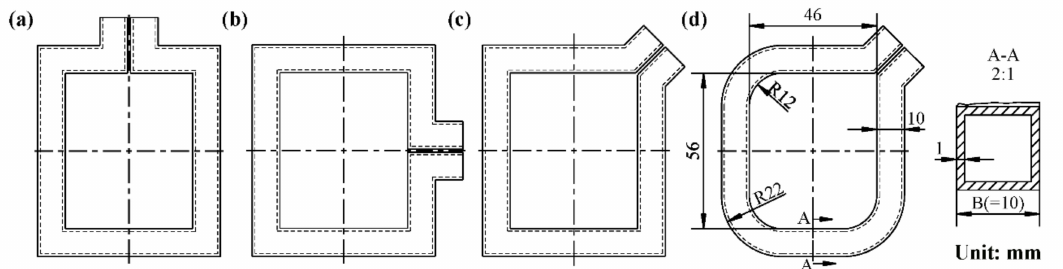
Figure 10. Different inductor structures: ( a ) The current input and output terminals are located on the short side of the inductor; ( b ) The current input and output terminals are located on the long side of the inductor; ( c ) The current input and output terminals are located on the diagonal of the inductor (non-uniform clearance between the inductor and the rectangular tube); ( d ) The current input and output terminals are located on the diagonal of the inductor (uniform clearance between the inductor and the rectangular tube).